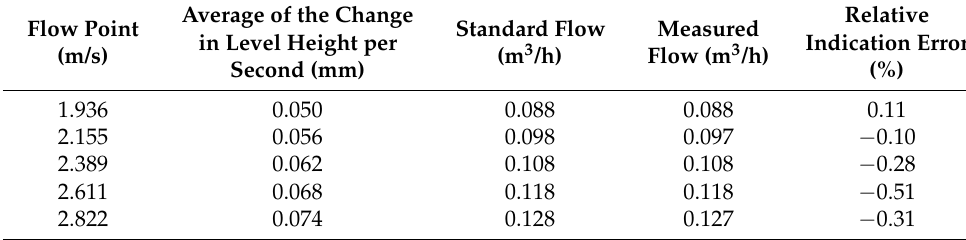
Table 3. Measurement results under DN6 pipe diameter.